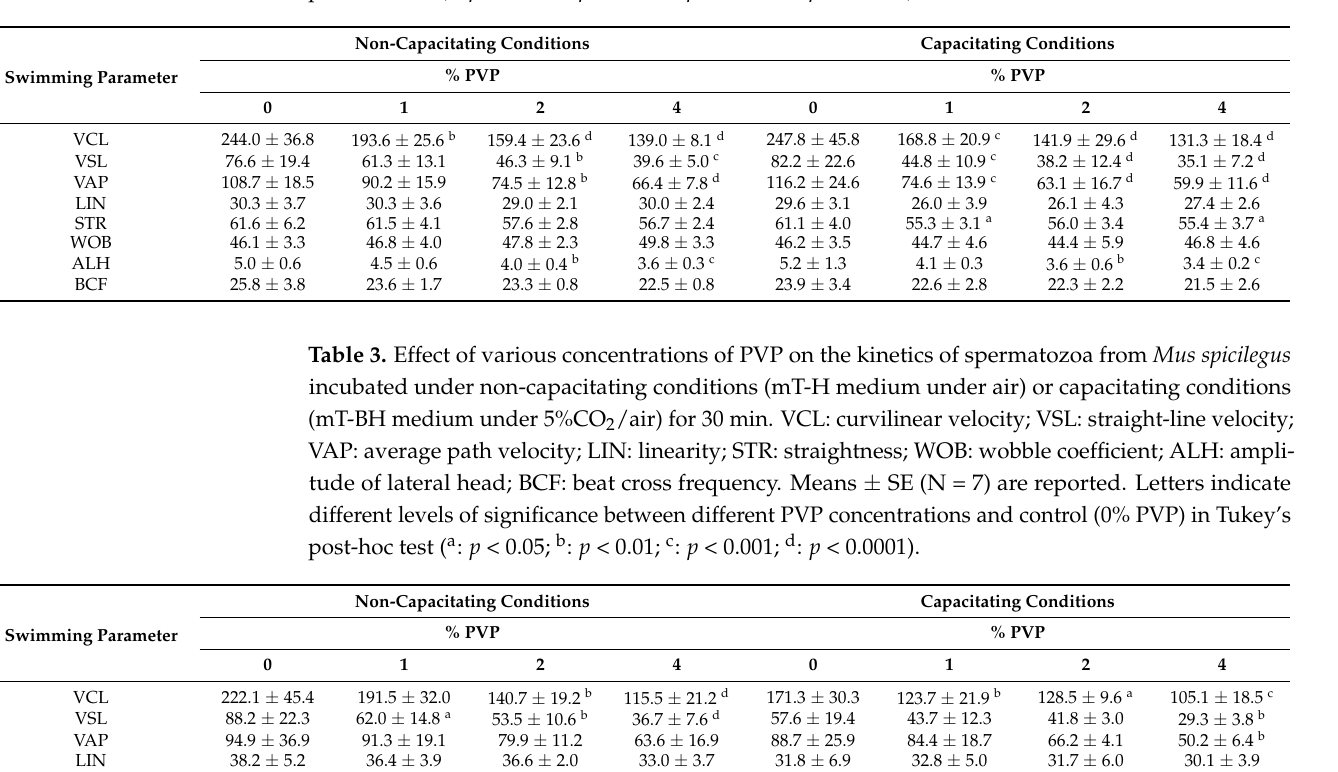
Table 2. Effect of various concentrations of PVP on the kinetics of spermatozoa from Mus spretus incubated under non-capacitating conditions (mT-H medium under air) or capacitating conditions (mT-BH medium under 5%CO 2 /air) for 30 min. VCL: curvilinear velocity; VSL: straight-line velocity; VAP: average path velocity; LIN: linearity; STR: straightness; WOB: wobble coefficient; ALH: ampli- tude of lateral head; BCF: beat cross frequency. Means ± SE (N = 7) are reported. Letters indicate different levels of significance between different PVP concentrations and control (0% PVP) in Tukey’s post-hoc test ( a : p < 0.05; b : p < 0.01; c : p < 0.001; d : p < 0.0001).